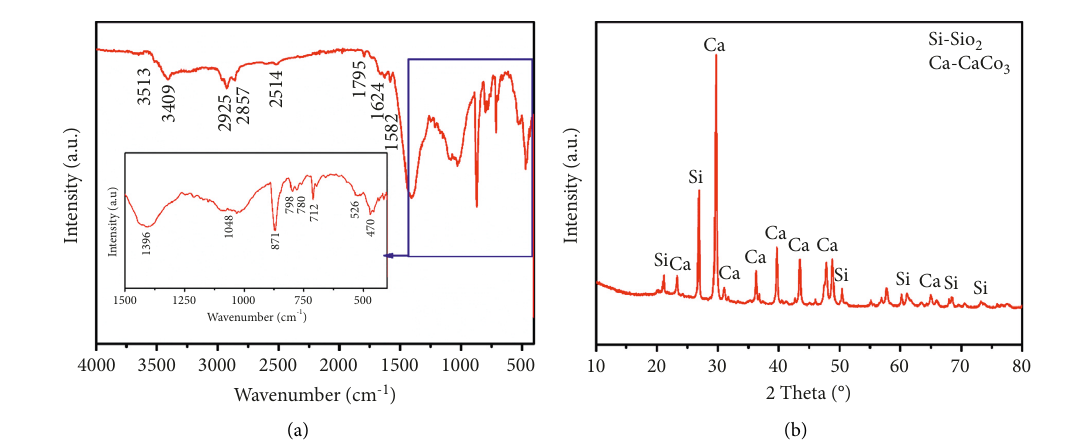
Figure 2: FTIR and XRD pattern of WDC